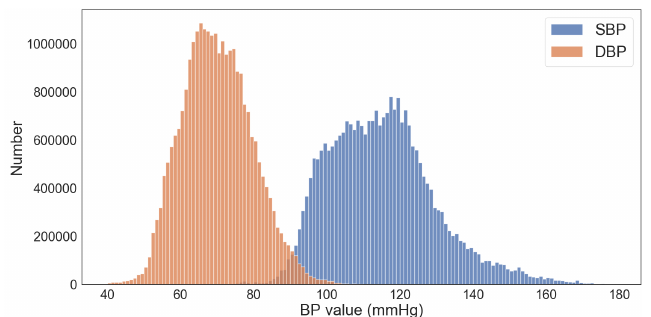
Figure 3. Distribution of BP values in the dataset used in this study.